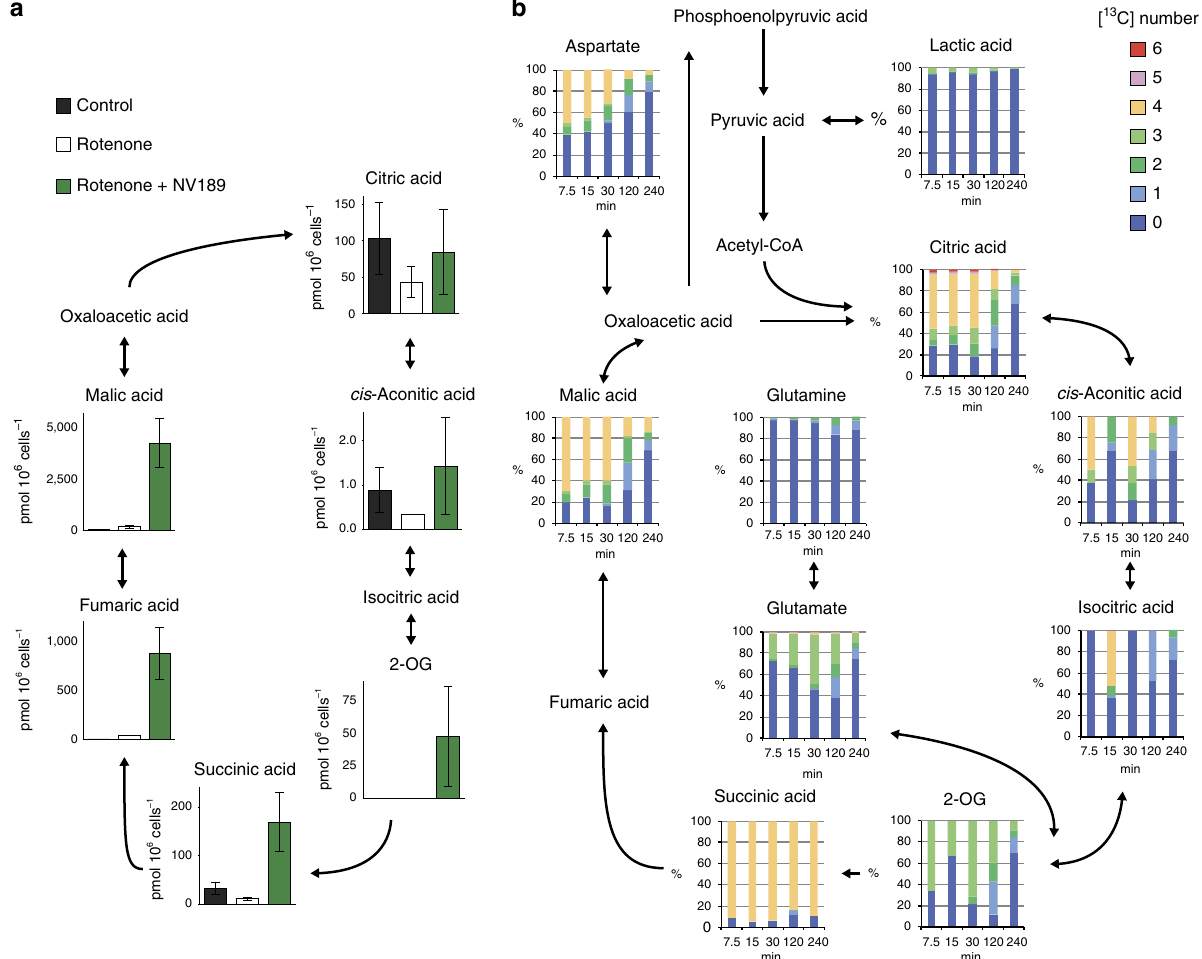
Figure 2 | Intracellular metabolism of exogenous prodrug-delivered succinate. ( a ) TCA cycle intermediates in peripheral blood mononuclear cells after 20min incubation with or without rotenone and NV189 quantified using capillary electrophoresis mass spectrometry, n ¼ 4. Data presented as mean and s.d. ( b ) Fraction of [ 13 C] isotope labelled carbons in TCA cycle intermediates and related metabolites in human platelets incubated with [1, 2, 3, 4- 13 C 4 ]NV118 for 7.5, 15, 30, 120 or 240min. Mean of n ¼ 2. 2-OG, 2-oxoglutaric acid.